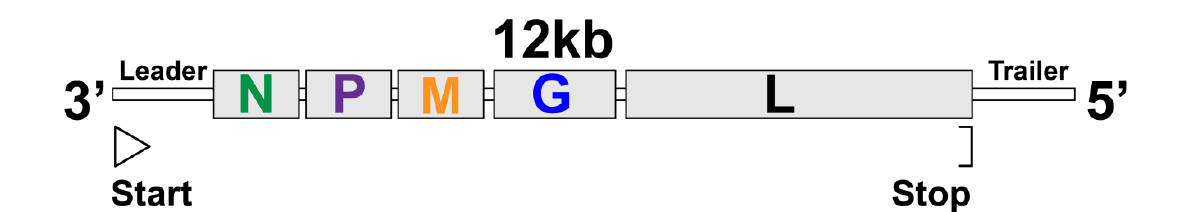
Figure 5. Graphical depiction of the genomic organization shared among the viral order of Mononegavirales . N, nucleoprotein; P, phosphoprotein; M, matrix protein; G, glycoprotein; L, Large protein.